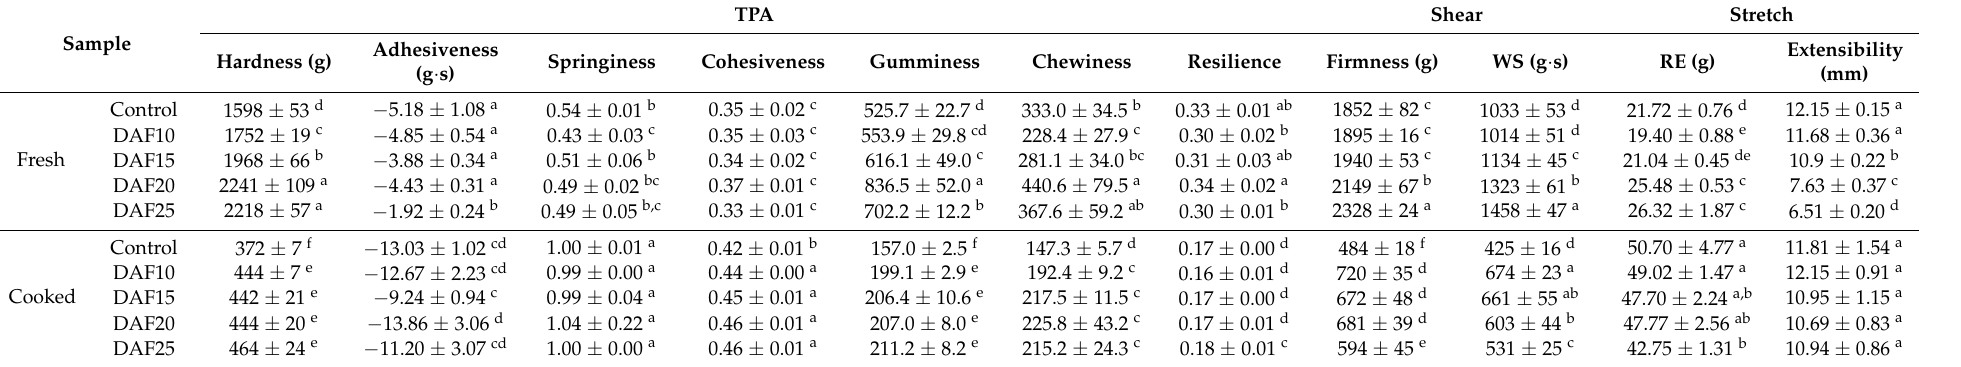
Table 5. Textural parameters of fresh wheat noodles with different substitution levels of acorn flour a,b,c